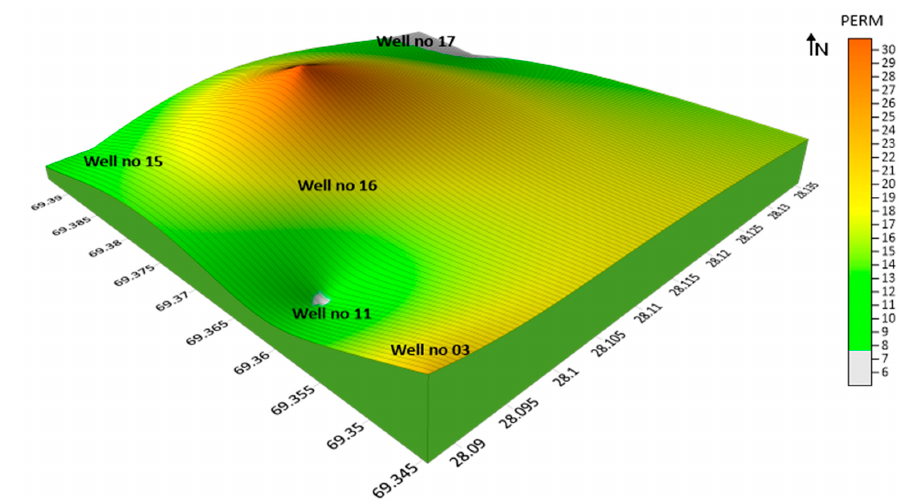
Figure 16. Permeability (PERM) variation map computed in (%).